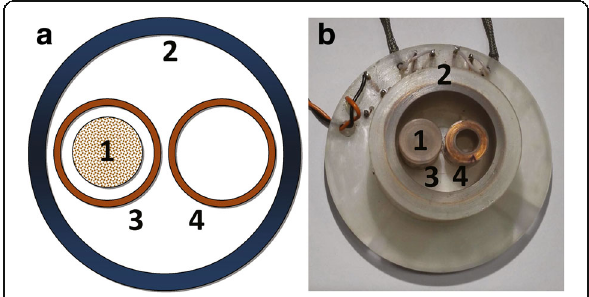
Fig. 1 Schematic mutual position of coils ( a ) and measuring cell ( b ). 1 — sample, 2 — excitation coil, 3 — signal coil, 4 — compensation